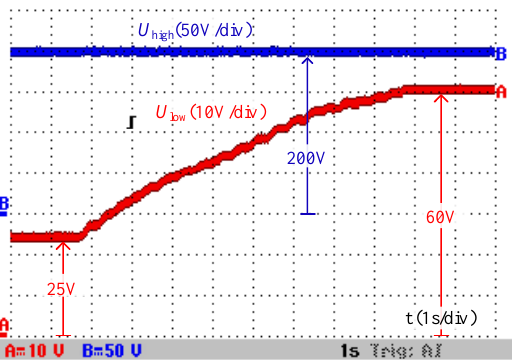
Figure 15. The output voltage and the wide-range changed input voltage from 25 V to 60 V in step-up